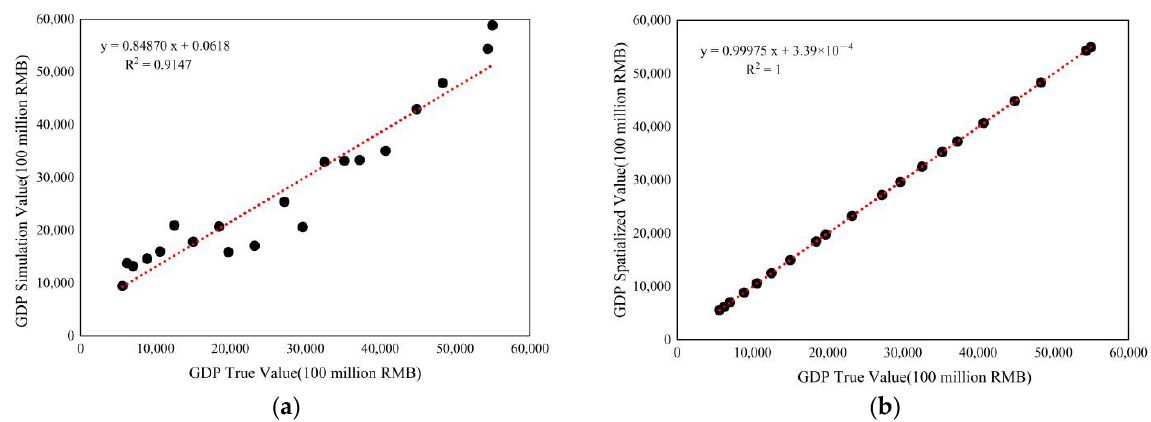
Figure 8. Relationships between GDP simulation values, GDP spatialized values, and GDP true values in Henan Province from 2001 to 2020: ( a ) GDP simulation values and GDP true values, ( b ) GDP spatialized values and GDP true values.